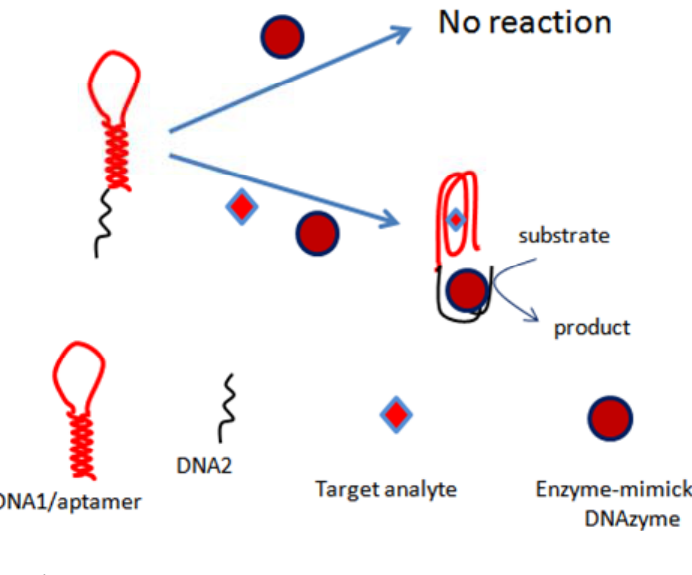
Figure 3. Aptamer-DNAzyme hairpins for biosensing of ochratoxin A